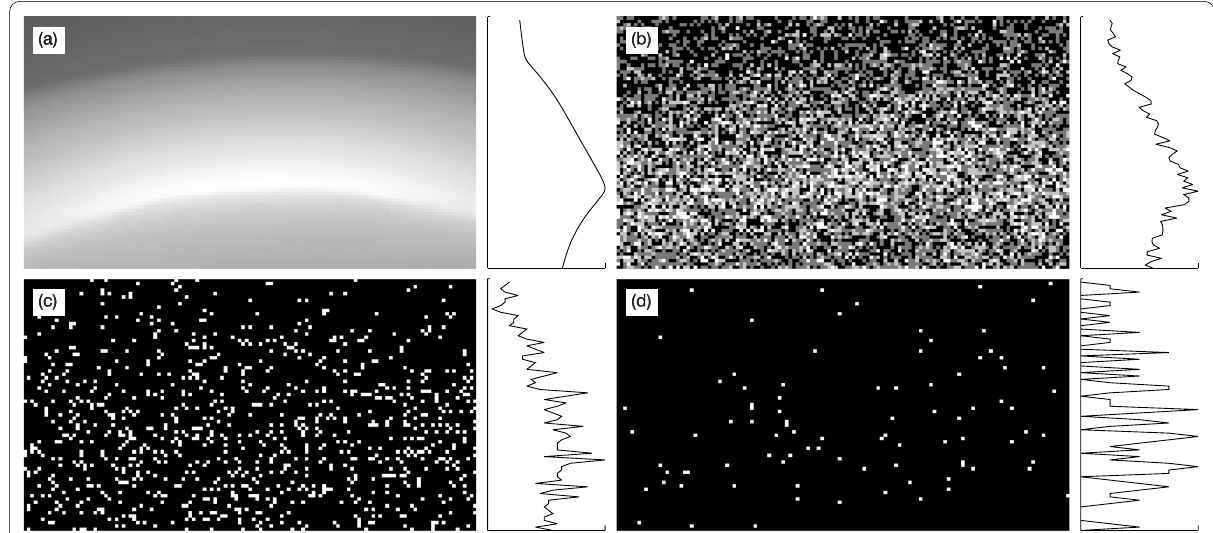
Fig. 5 Simulated soft X-ray images. Simulated images of soft X-ray images from the MHD model with dimensions 75 by 129 pixels. a Noise-free image, b image with average 1 photon per pixel, c 0.1 photons per pixel, and d 0.01 photons per pixel, assuming Poisson statistics. The curve on the right side of each image is the horizontal integral of the photons (Figure adapted from Jorgensen et al. (2019a))